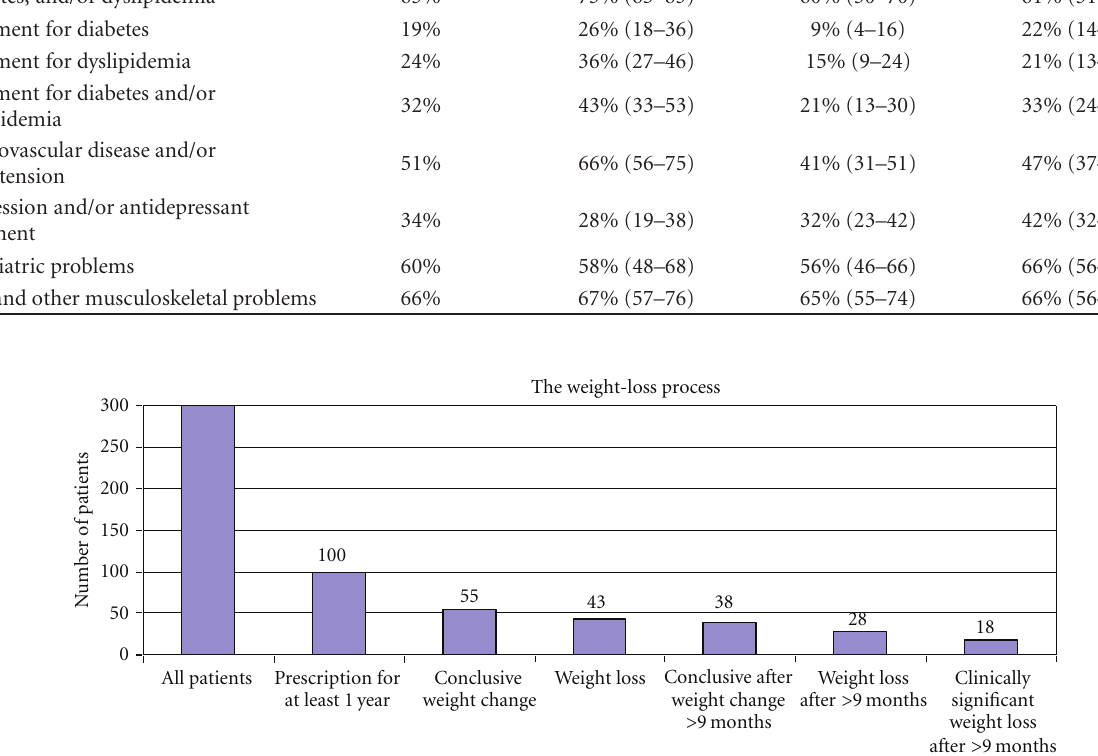
Figure 1: The weight loss